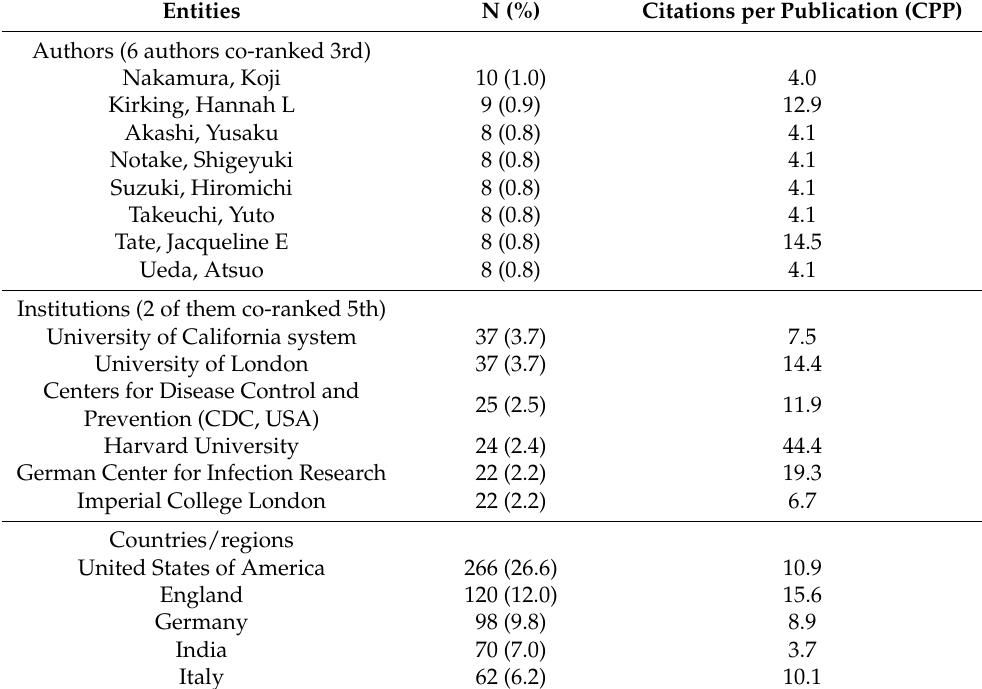
Table 1. Top five most productive entities in terms of authors, institutions, countries, journals, and journal categories of the literature concerning the COVID-19 rapid antigen test (N—number of